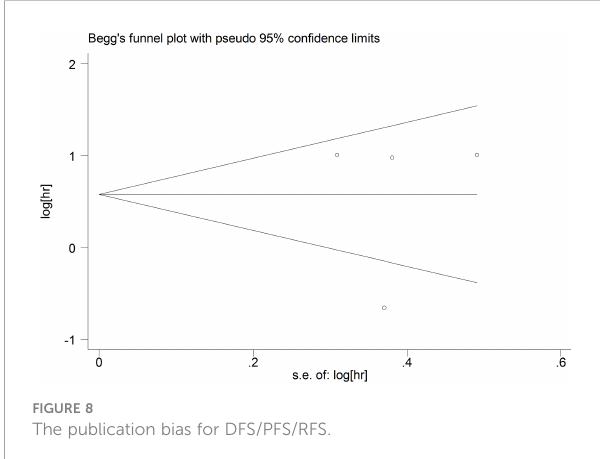
FIGURE 5 Sensitivity analysis for OS.